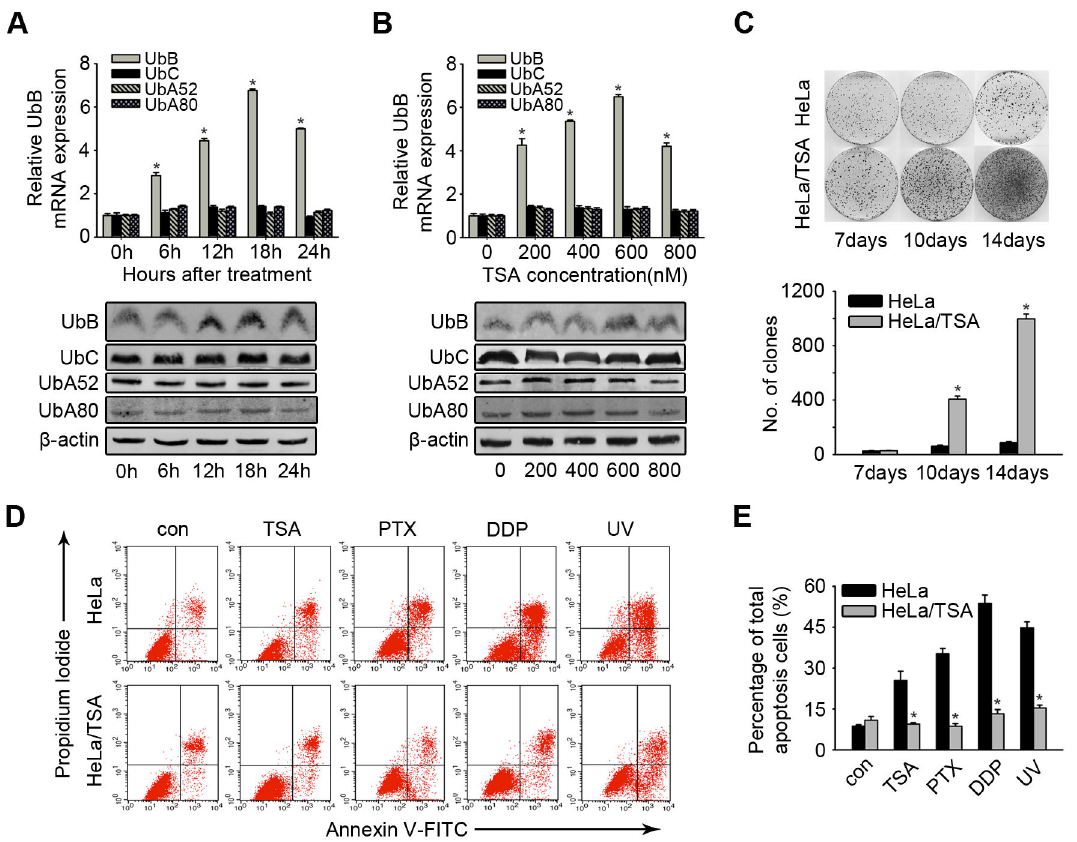
Figure 1. The increasing effect of colony formation and drug-resistance in HeLa/TSA. A , HeLa cells were treated with 500 nM TSA for the indicated times and subjected to analysis the mRNA level of UbB, UBC, UbA52 and UbA80 by real-time PCR and the corresponding protein level by western blotting. B , HeLa cells were incubated with TSA for 24 hours at a dose ranging from 200 to 800 nM and subjected to analysis the mRNA level of UbB, UbC, UbA52 and UbA80 by real-time PCR and the corresponding protein level by western blotting. C , Upper panel: representative dishes of the colony forming assay at day 7, 10 and 14. Lower panel: numbers of colony formed in HeLa and HeLa/TSA at day 7, 10 and 14. The columns represent the average of three separate experiments; error bars, SD; *, p <0.05. D , HeLa/TSA cells were treated with TSA (1 μM), DDP (30 μM), and PTX (75 nM) for 48 h or UV, the apoptosis cells were quantified by Annexin V/PI staining and the flow cytometry analysis. The representative examples of the flow cytometry results were shown. E , Cells were treated as described in D , the average percentages of apoptosis cells were reported in the graphs. Values, mean percentages; error bars, SD; *, p < 0.05 (n = 3 replications). doi: